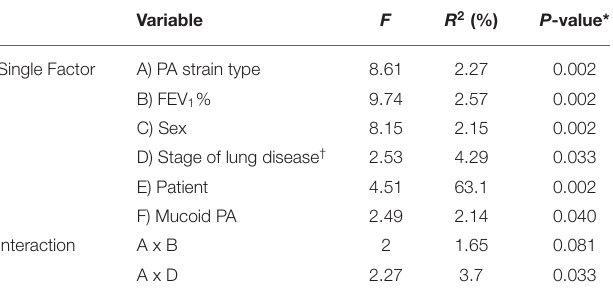
TABLE 3 | CF bacterial community structure variation explained by various factors and their interactions based on Bray-Curtis distances in 116 samples that were P. aeruginosa- culture